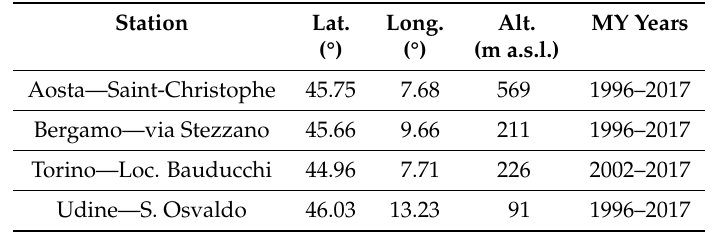
Table 1. Positions of the considered weather station and length of the multi-year record. Station Lat.